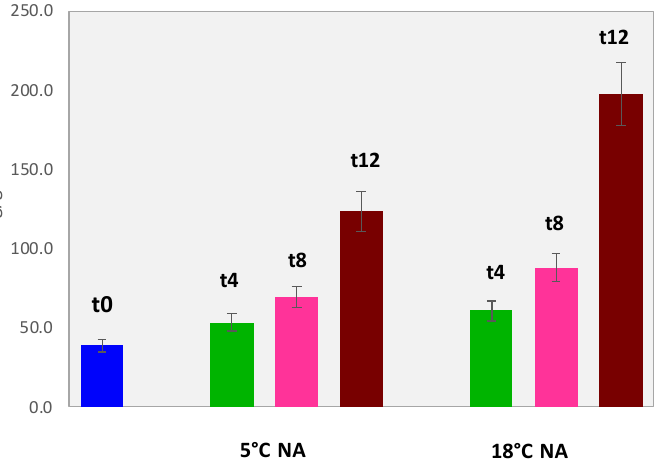
Figure 7. Histogram reporting hexanal equivalents (ng/g) for pineapple samples analyzed at the different shelf-life time points and storage conditions.